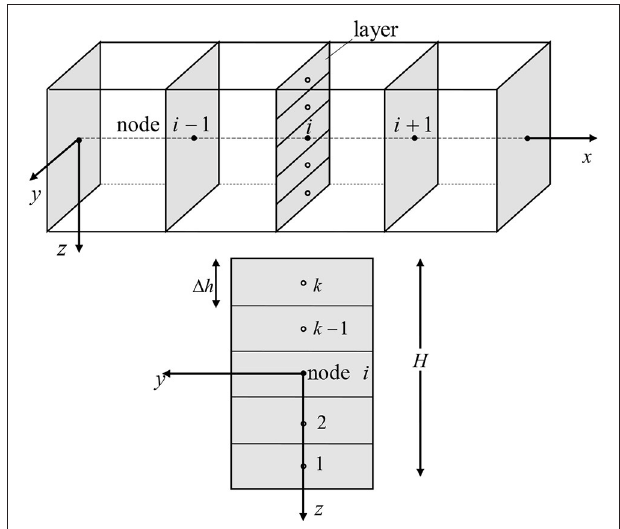
FIGURE 2 | Discretization of the beam into monitoring cross-sections and cross-section